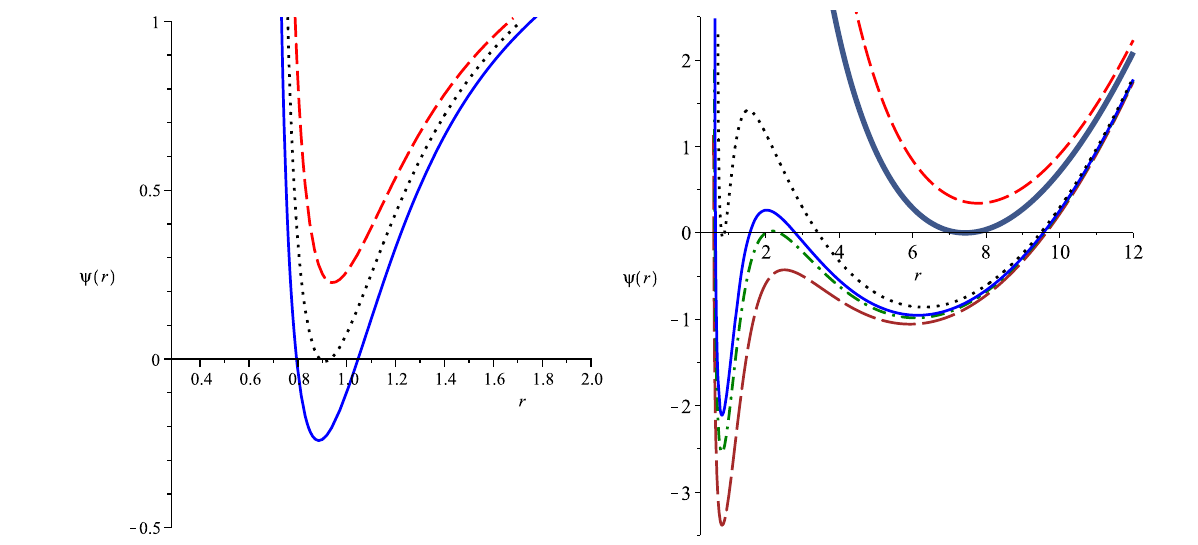
Fig. 5 ψ( r ) versus r for k = 1, d = 7, (cid:8) = − 1, q = 2 . 4, α = 0 . 2. Left panel: for Lovelock gravity with m 0 = 2 (solid line), m 0 = 1 . 75 (dotted line) and m 0 = 1 . 5 (dashed line). Right panel: for Lovelock massive (LM) gravity with m 0 = 1 . 2, m = 0 . 8, c 0 = 1, c 1 = − 5,